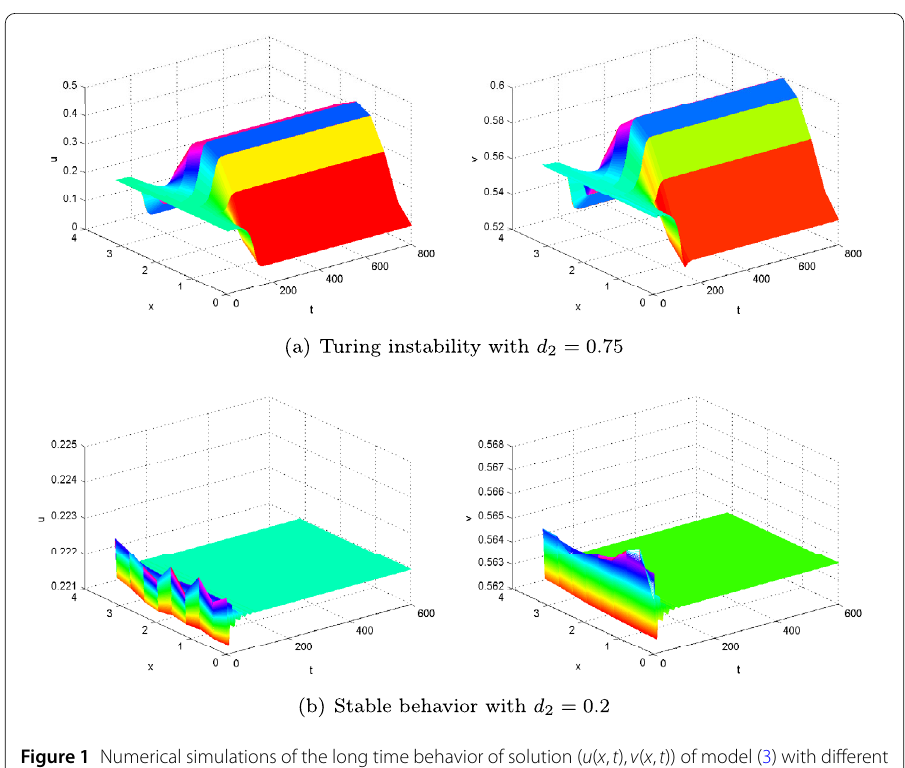
Figure 1 Numerical simulations of the long time behavior of solution ( u ( x , t ), v ( x , t )) of model (3) with different values of d